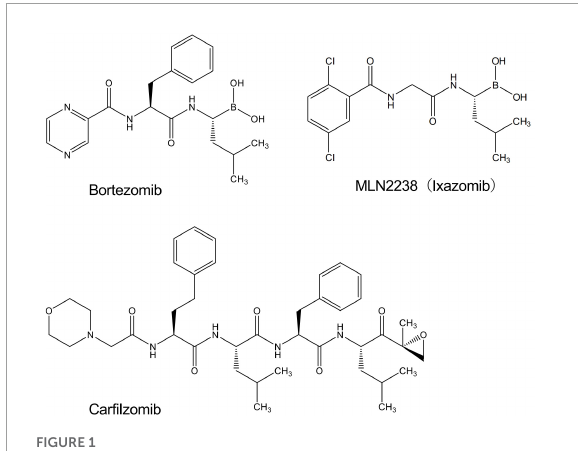
FIGURE1 Chemical structures of drugs used in the present